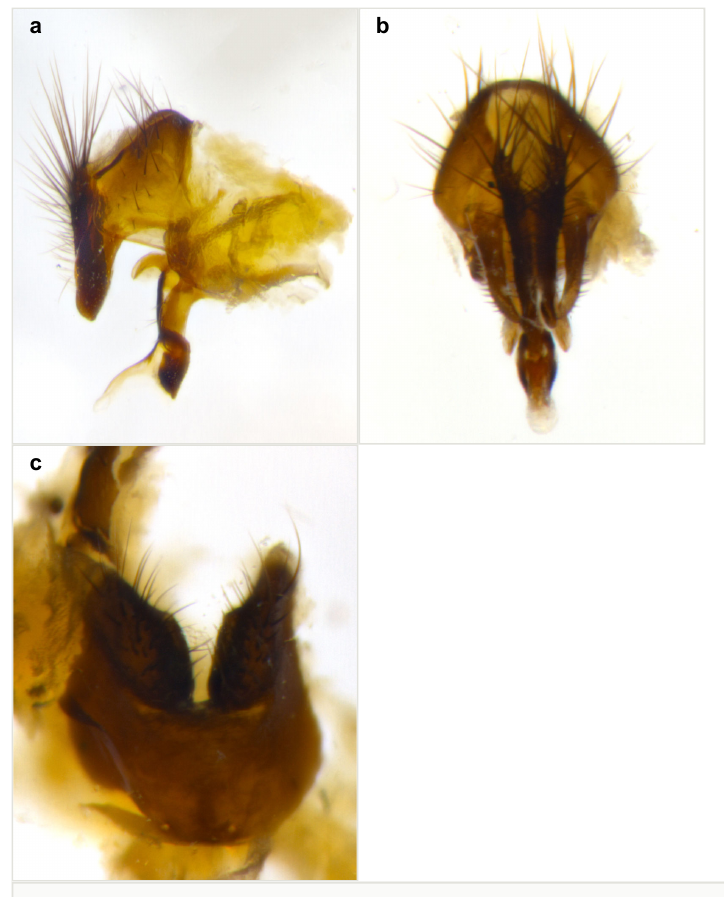
Male terminalia of Calolydella timjamesi sp. n. ; a–c : paratype, voucher n.